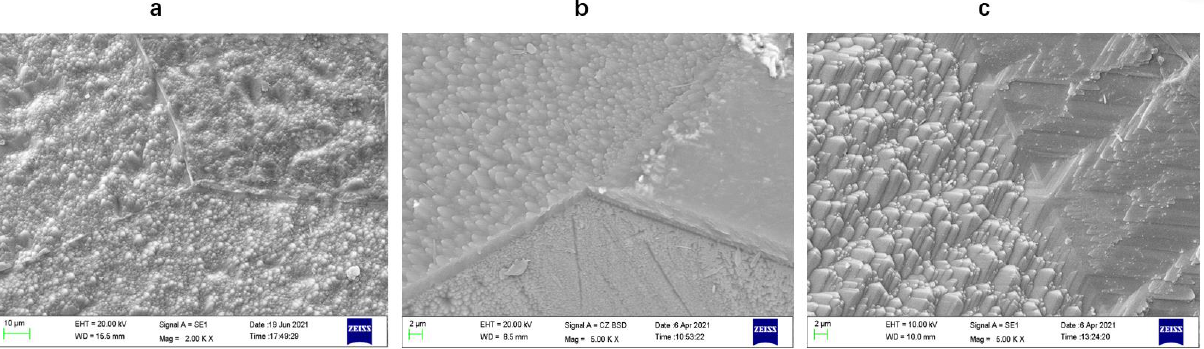
Figure 8. SEM images of Mc-Si wafer after etching. ( a ) Electrophoretic deposited quartz powder, ( b ) sprayed quartz powder, and ( c ) silicon particles.